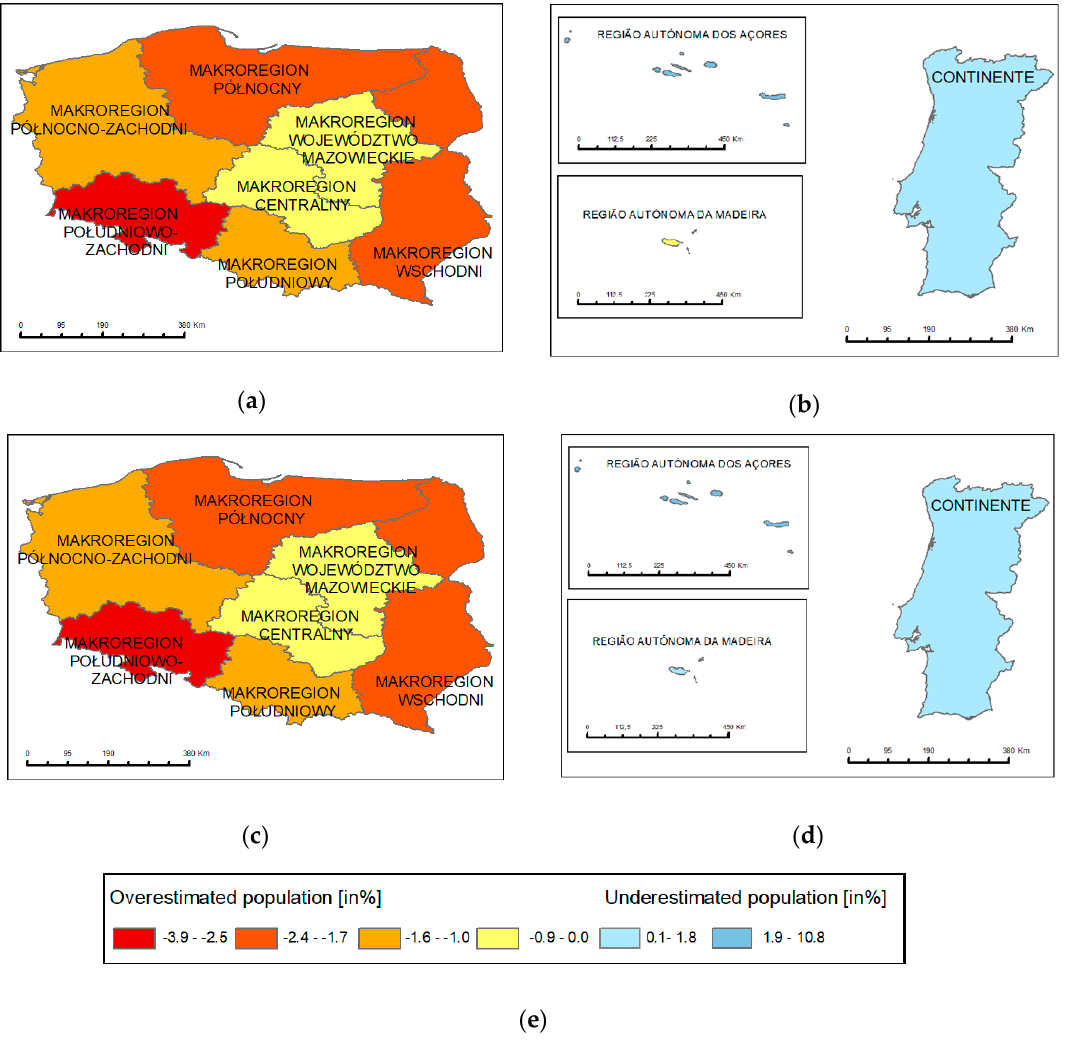
Figure 7. NUTS 1: MAPE. ( a ) GHS-POP 250 m, Poland; ( b ) GHS-POP 250 m, Portugal; ( c ) GHS-POP 1 km, Poland; ( d ) GHS-POP 1 km, Portugal; ( e ) map legend.